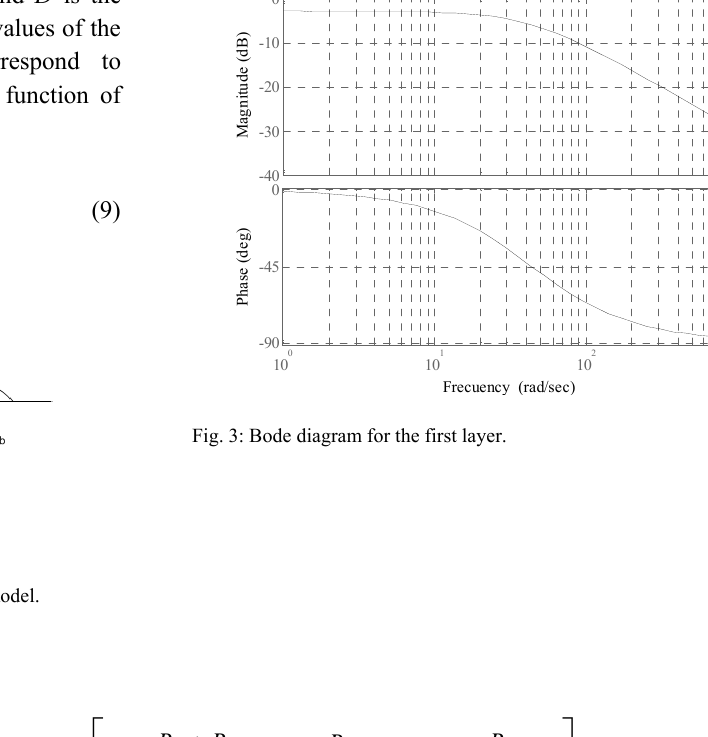
Fig. 3 shows the corresponding Bode plot.